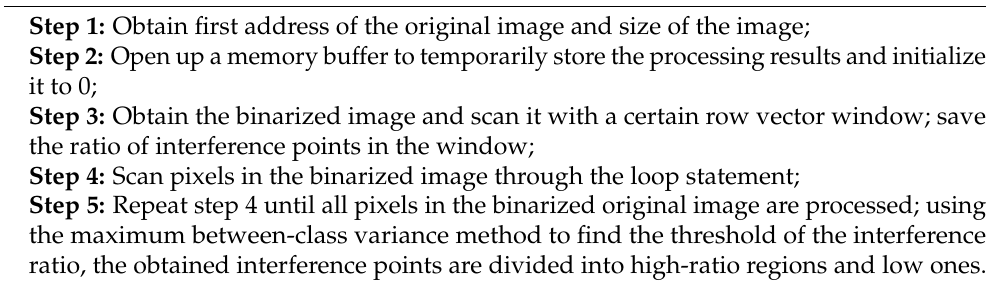
Algorithm 2 Tangential interference ratio model